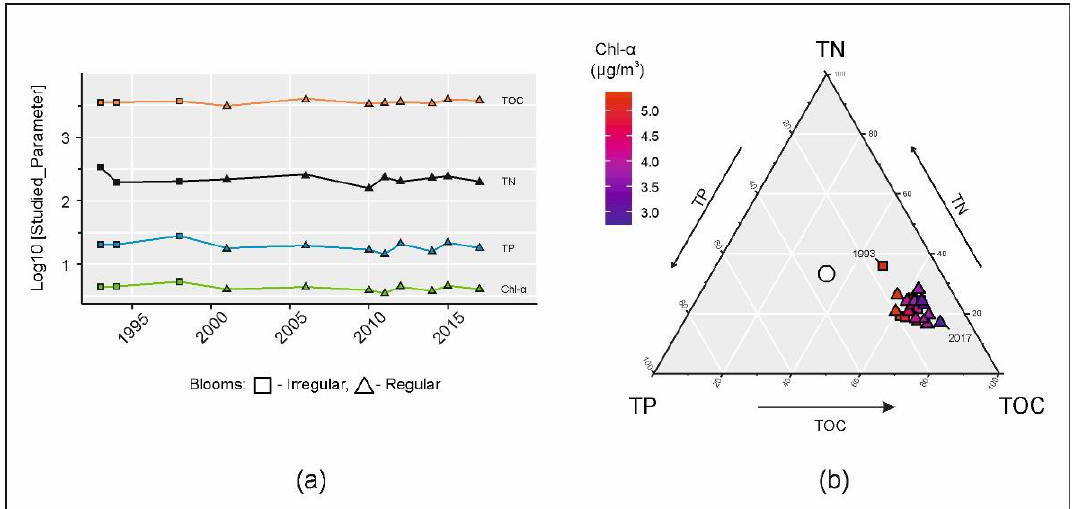
Figure 6. Dynamics of the mean concentration of TOC (µg-C/L), TP (µg-P/L), TN (µg-N/L), and Chl-a (µg/m 3 ) in 1993–2017 ( a ). Squares and triangles reflect the regularity of HABs (square—irregular; triangle—regular). Concentrations of TOC, TP, TN, and Chl-a during HABs in Lake Imandra in 1993–2017. The values are expressed as relative percentages of their Redfield sum. The white circle represents the optimal Redfield ratio ( b ).